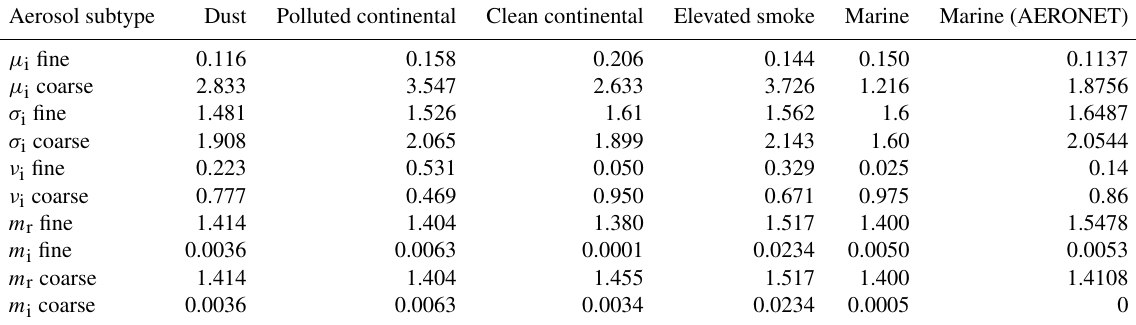
Table 3. Bimodal lognormal size distribution parameters and refractive indices (real part ( m r ) and imaginary part ( m i )) of the aerosol